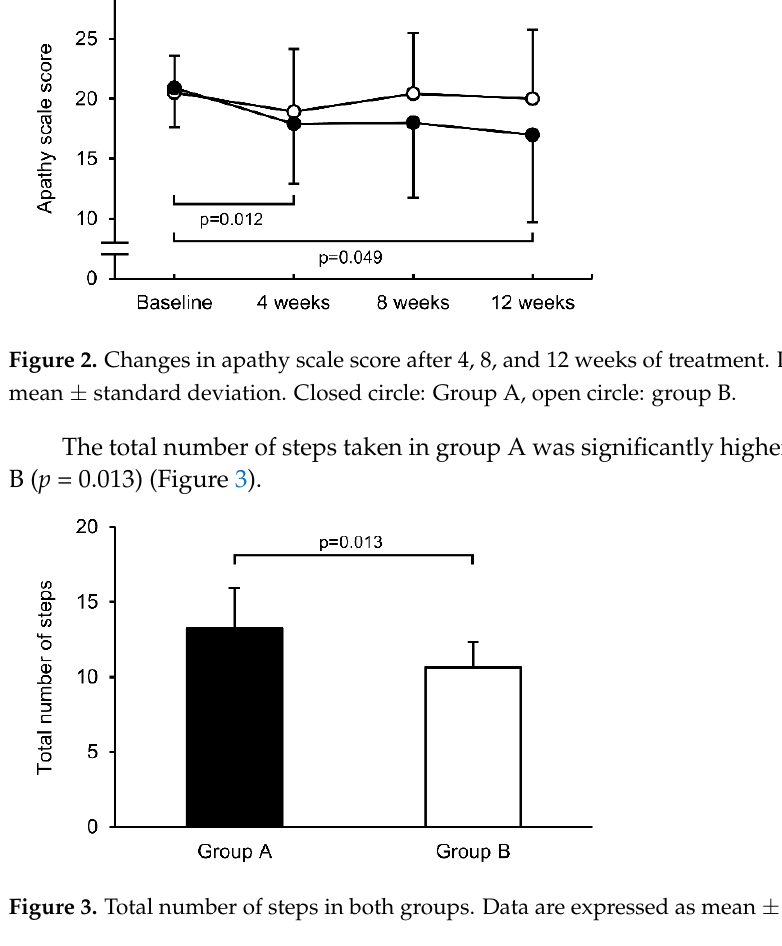
Figure 1. CONSORT flow diagram.